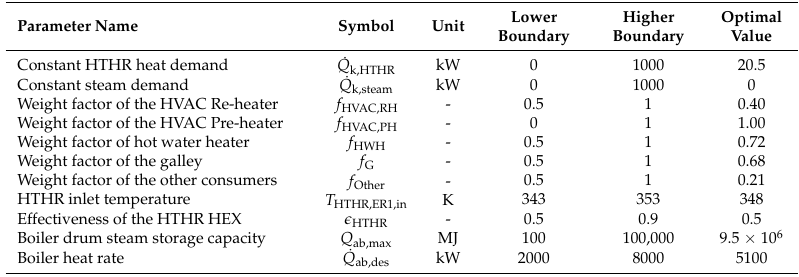
Table A6. Parameters optimized in the parameter estimation for the heat